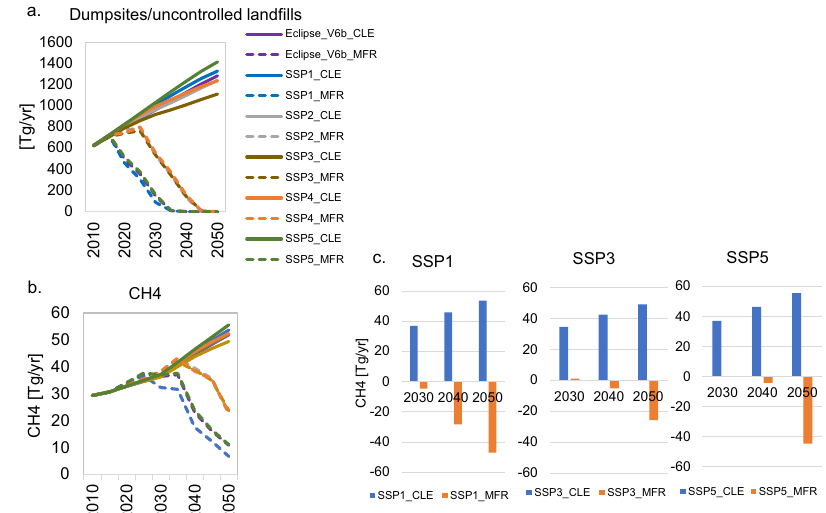
Fig. 4 Global methane emissions under baseline and mitigation scenarios. a Municipal solid waste (MSW) in dumpsites, b Methane (CH 4 ) emissions and c CH 4 reduction potentials (negative values in y -axis in panel c refer to avoided emissions). Faster adoption of measures improving MSW systems will result in an early decrease of MSW ending up in dumpsites/uncontrolled land fi lls and therefore brings quicker reductions of future CH 4 emissions from this source. Supplementary Information section 2 presents a detailed analysis of the mitigation (MFR)